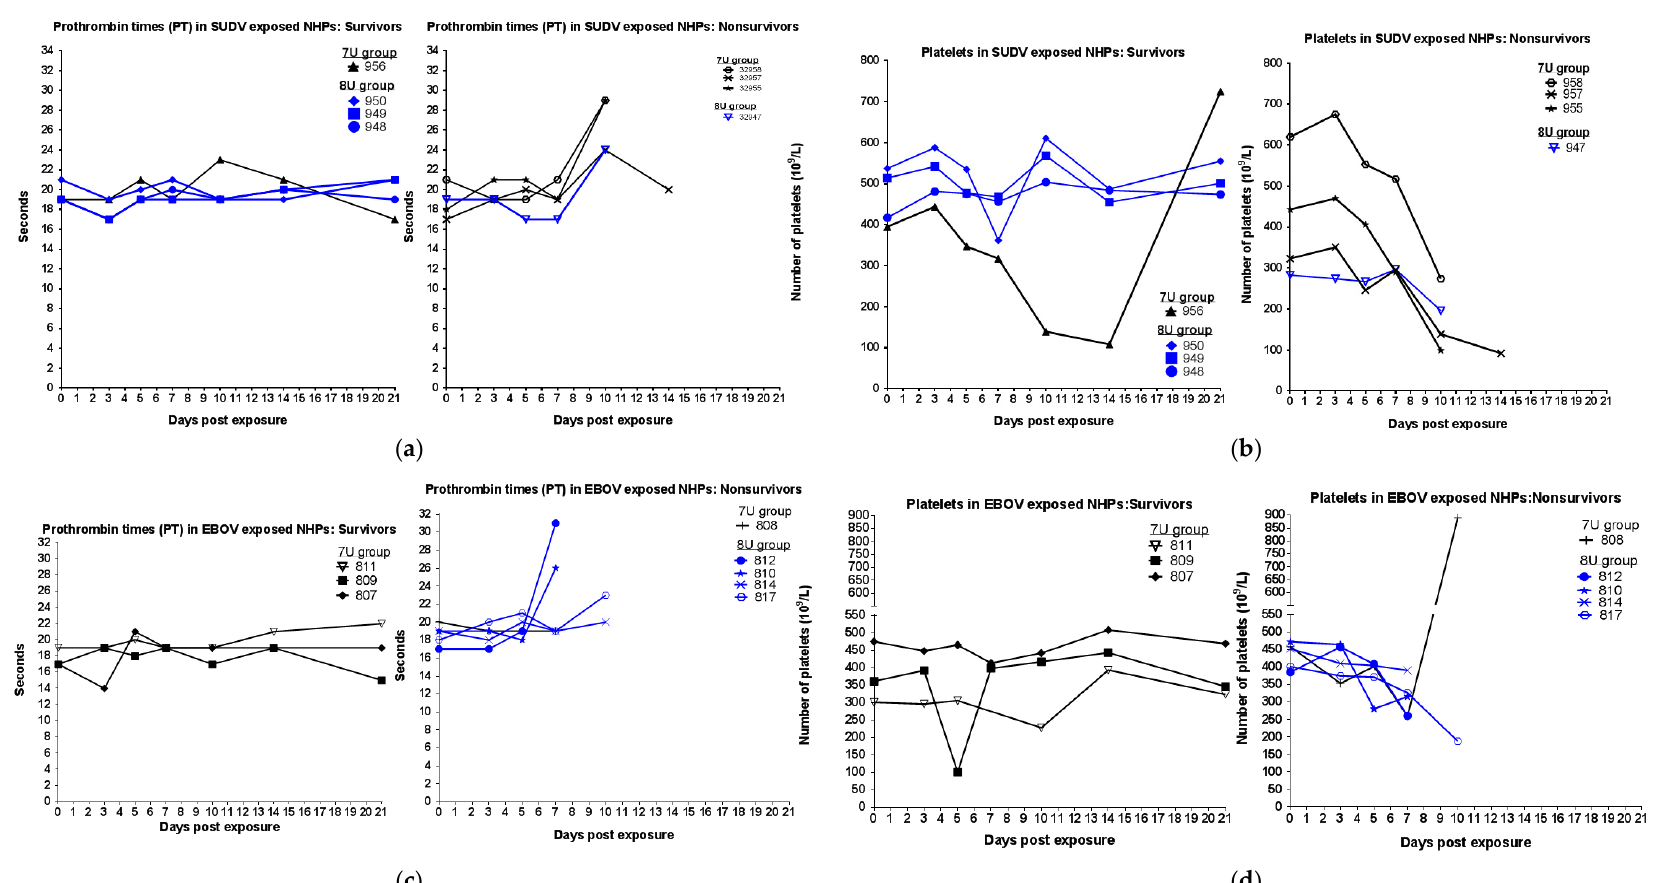
Figure 4. Coagulation parameters in Macaca fascicularis exposed to low doses of Sudan virus (SUDV) or Ebola virus (EBOV). M. fascicularis were experimentally exposed to 0.01 plaque forming units of either SUDV or EBOV with 7-uridine (7U) or 8-uridine (8U) genotype. During each scheduled sedation, and when possible at the time of death, blood specimens were collected and analyzed. Results of coagulation analysis for all animals throughout the course of the study are shown. NHPs—nonhuman primates. ( a ) Prothrombin times (PT) in SUDV-exposed NHPs. ( b ) Platelets in SUDV-exposed NHPs. ( c ) Prothrombin times (PT) in EBOV-exposed NHPs. ( d ) Platelets in EBOV-exposed NHPs.